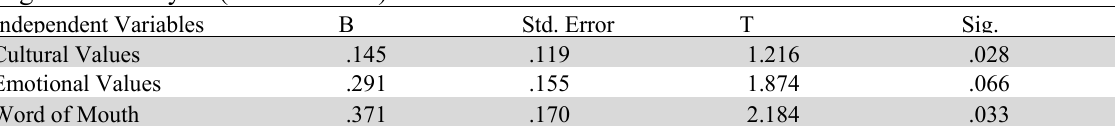
Regression analysis (overall effect) Independent Variables B Std.